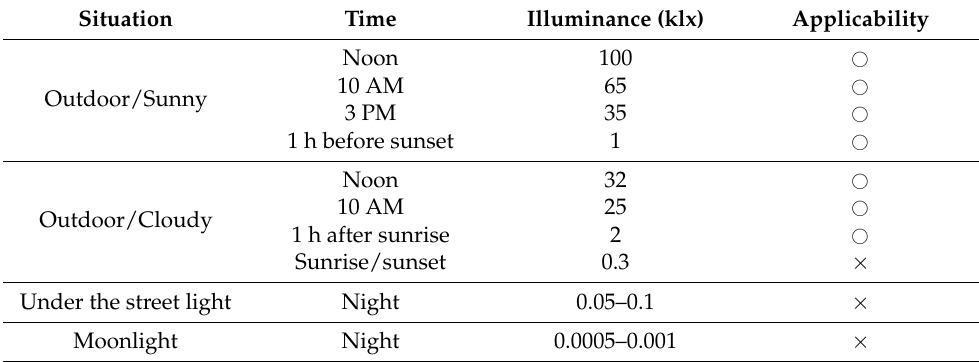
Table 8. Guideline for general illuminance and brightness